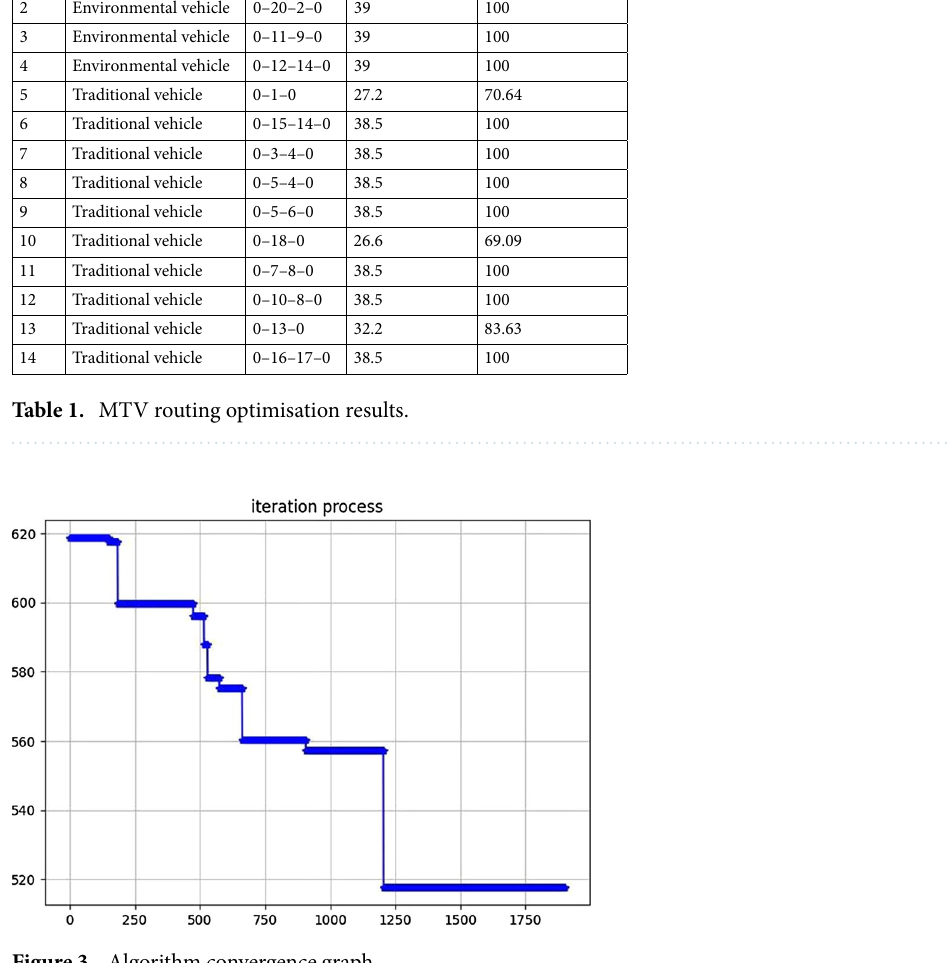
Algorithm convergence analysis. To test the computational efficiency and convergence performance of